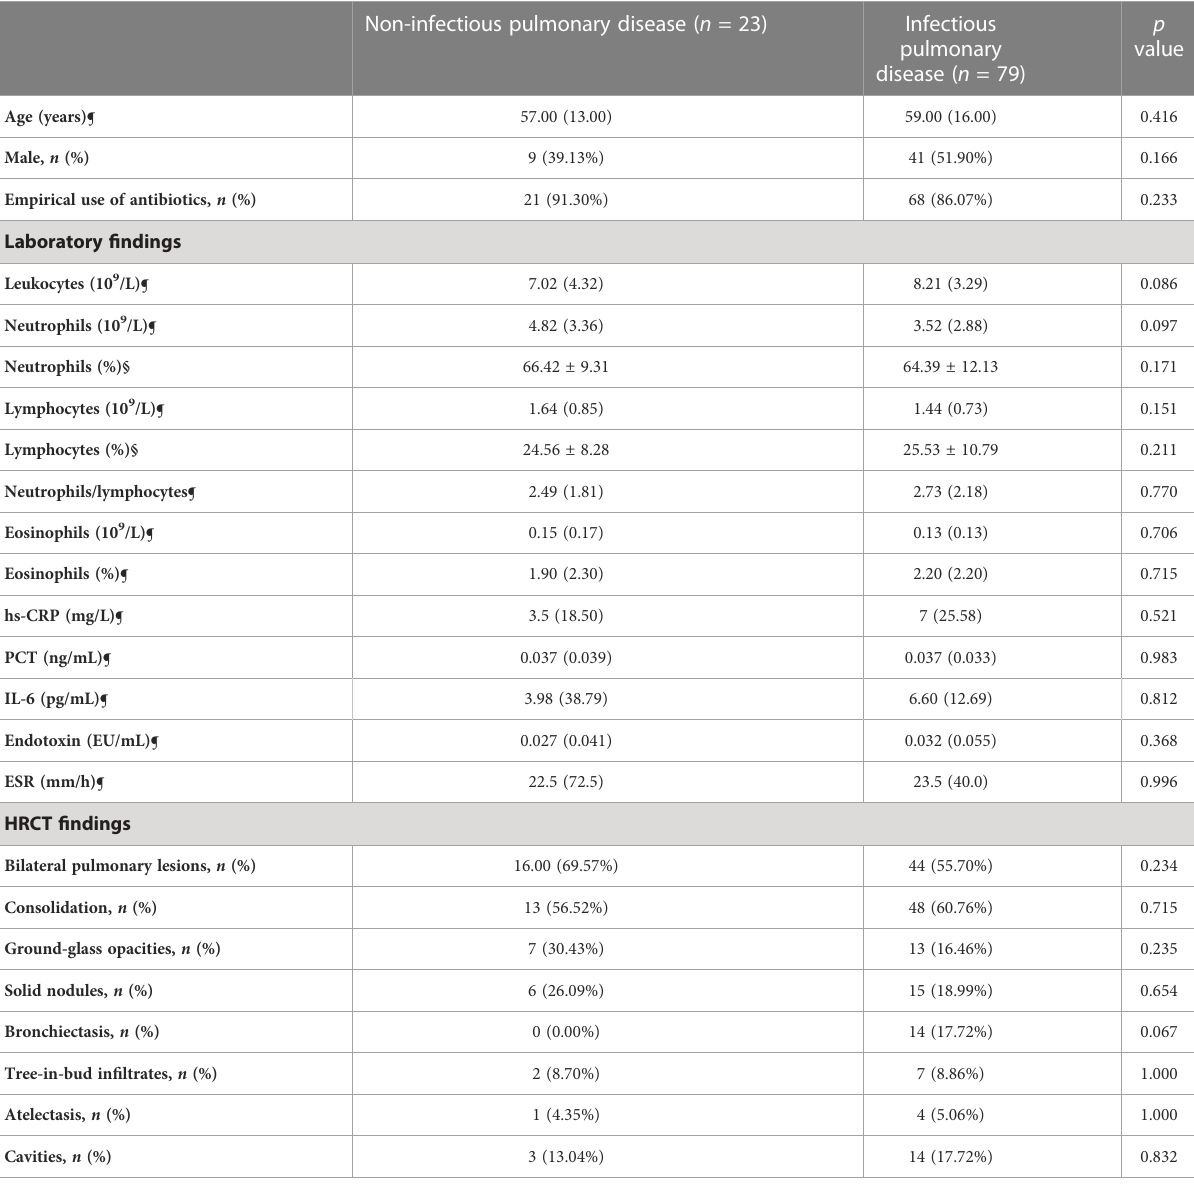
infectious disease via BALF mNGS was 97.8%, and the negative predictive value was 38.6%. The positive likelihood ratio was 12.81, and the negative likelihood ratio was 0.46. BALF mNGS increased the sensitivity rate by approximately 27% in comparison with CMTs (55.7% vs. 29.1%, p <0.01), whereas there was no signi fi cant difference in speci fi city (95.7% vs. 78.3%, p >0.1) (Figure 1A). Additional details are provided in Table